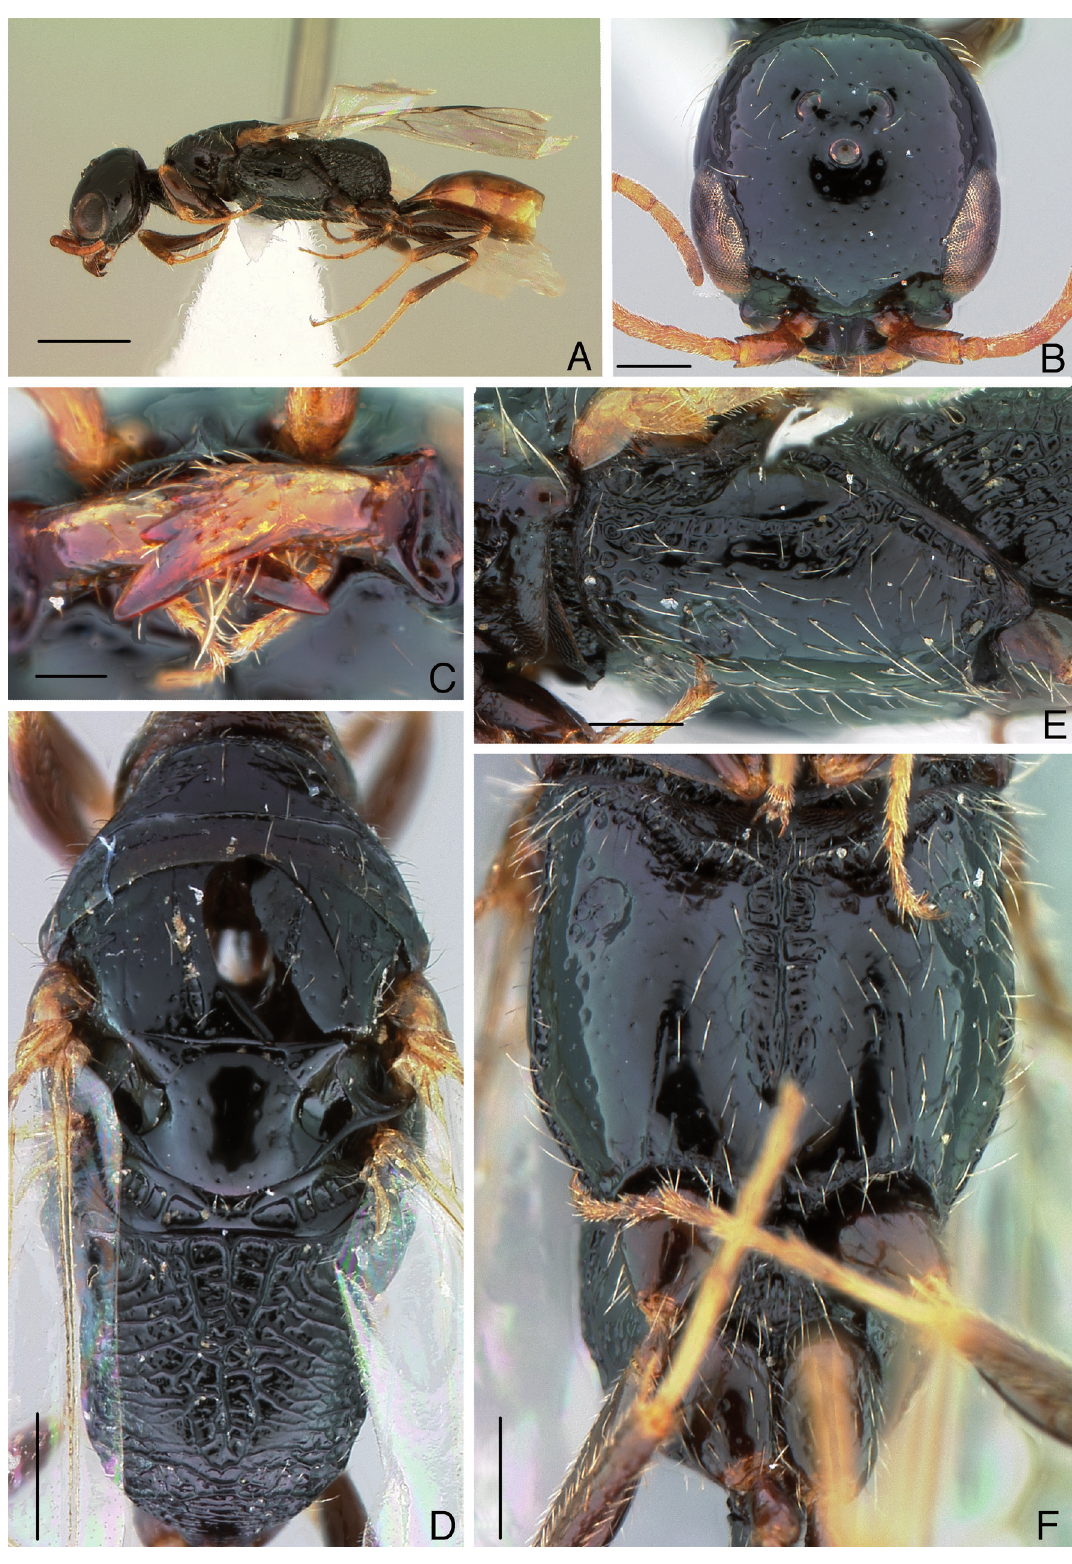
Fig. 1. Pristocera rufiventer comb. nov., holotype, ♂. A . Habitus. B . Head, dorsal view. C . Mandible, frontal view. D . Mesosoma, dorsal view. E . Mesopleuron, lateral view. F . Mesosoma, ventral view (bars 0.5